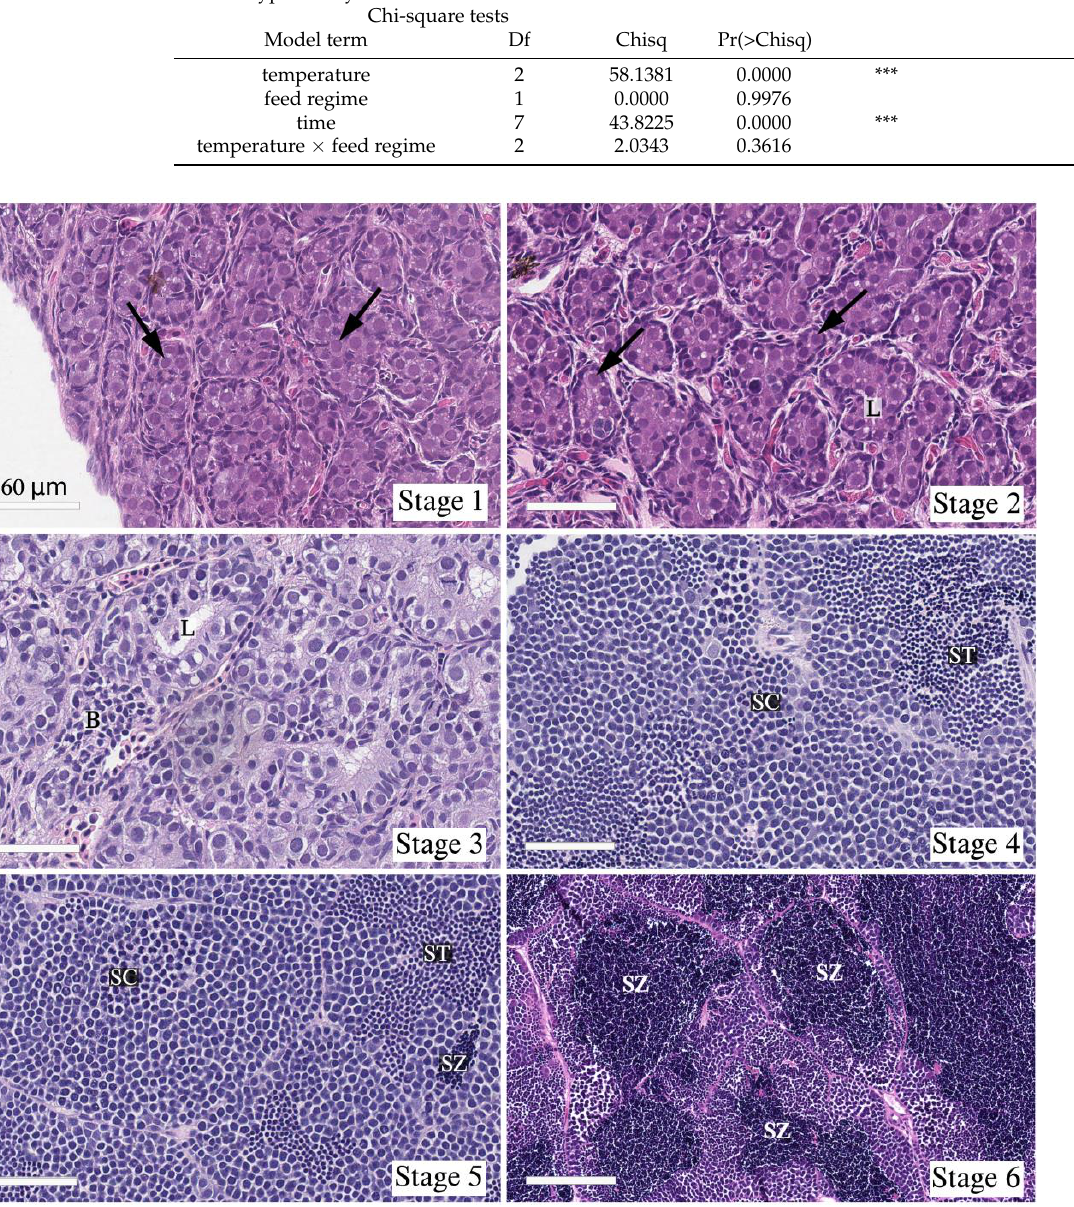
Figure 1. Examples of testis morphology observed after histology inspection, illustrating the six testis developmental stages. All images are in ×40 magnification. The clear rectangle at the bottom-left corner of the six images represents a length of 60 μm. Developmental stages are characterized by: Stage 1 — Type A spermatogonia as furthest developed germ cell type (black arrow); Stage 2 — Type A spermatogonia (black arrow) as furthest developed germ cell type and clear formation of tubule luminae (L); Stage 3 — Type A and B spermatogonia (B) as furthest developed germ cell type and clear formation of tubule luminae (L), but the majority of germ cells are type A spermatogonia; Stage 4 — Spermatocytes (SC) and spermatids (ST) as the furthest developed germ cell types, no presence of spermatozoa; Stage 5 — Spermatozoa (SZ) as the furthest developed germ cell type in some tubules, but not dominating; Stage 6 — Large numbers of spermatozoa (SZ) in most tubules.